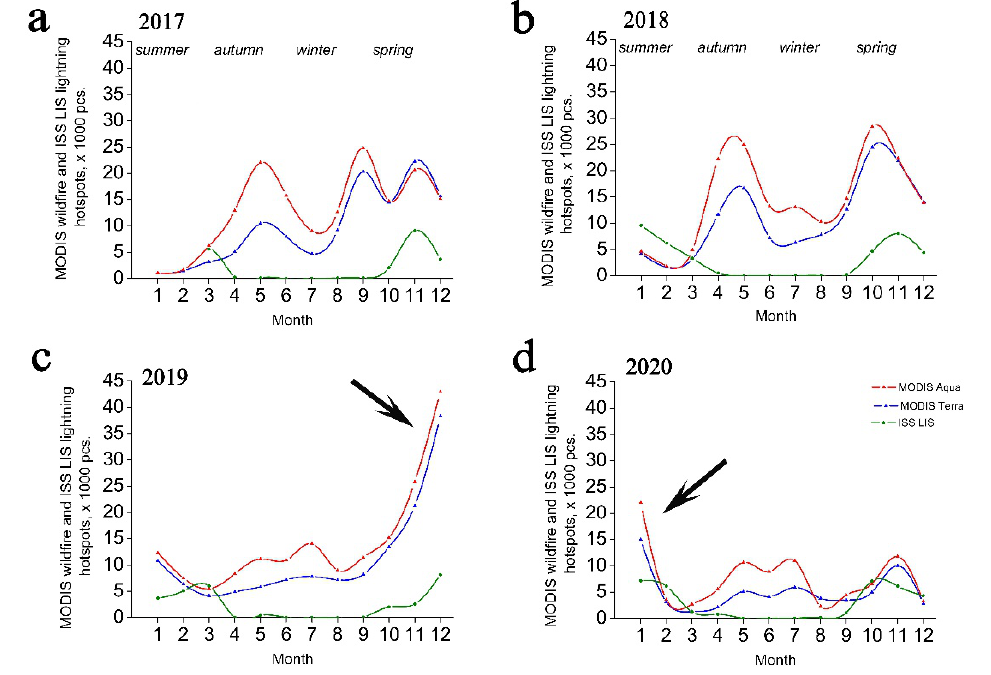
Figure 4. The comparison between monthly distributions of MODIS Terra (blue) and Aqua (red) wildfire hotspots, and the ISS LIS lightning flashes (green lines), for the 2017 ( a ), 2018 ( b ), 2019 ( c ); and 2020 ( d ). Abnormal numbers of wildfires in the spring and summer are marked by arrows.